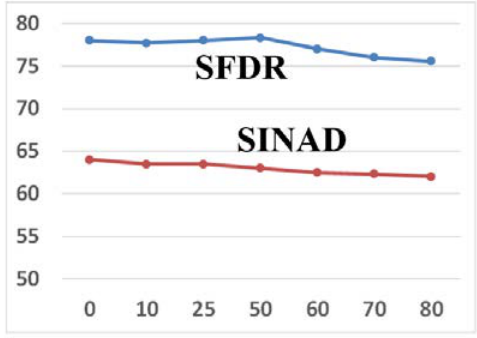
Figure 15. Dynamic performances under different temperatures.